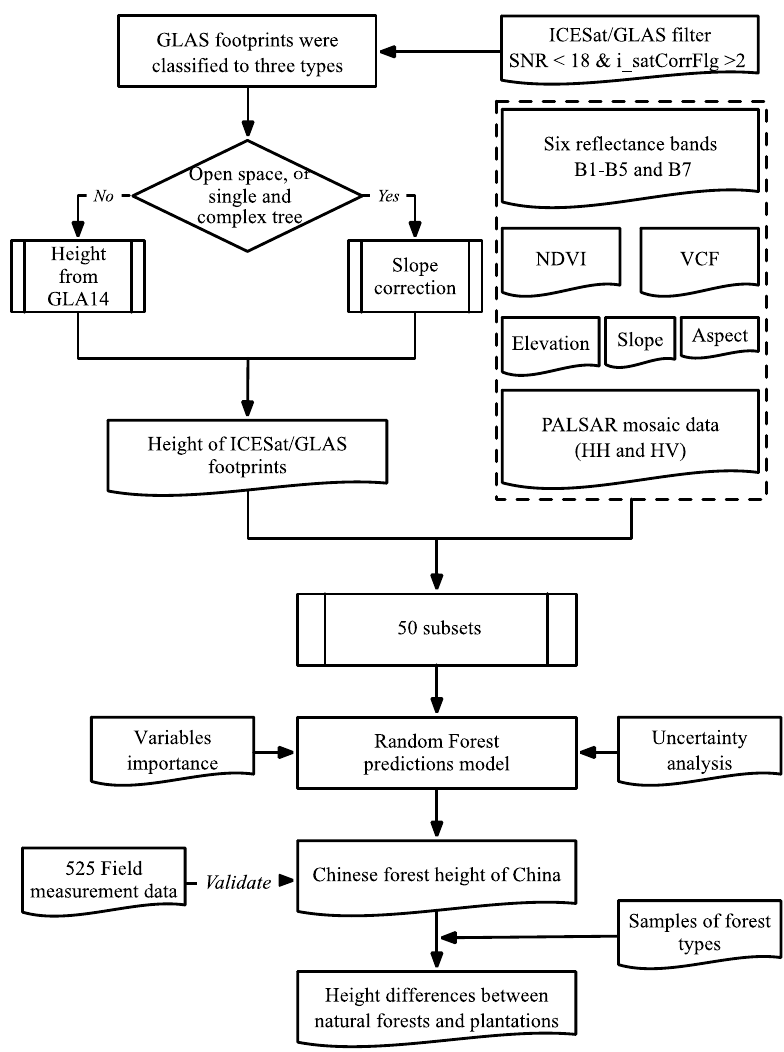
Figure 3. Overall workflow of finer resolution Chinese forest height mapping.